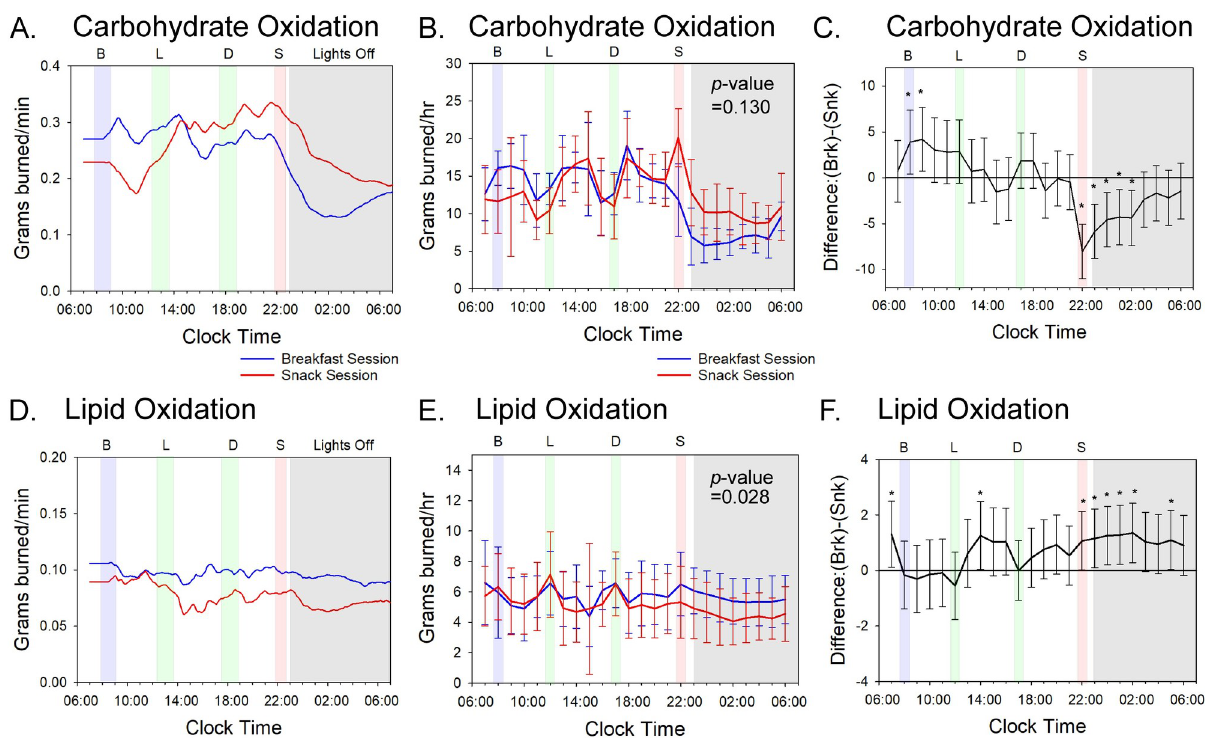
Fig 3. Meal timing alters substrate oxidation; see S5 and S6 Figs and S2E and S2F Table for underlying data and analyses. (A) CO data of a representative subject (#3) calculated from indirect calorimetry measurements as described [26,27].Data are plotted as a 3-h moving average (180-min data points). (B) Average of all subjects for daily CO calculated from indirect calorimetry measurements as described [26,27],and the 56-h time course data are plotted on a modulo-24 h scale. Averaged data for all subjects are organized in 1-h bins. The p -value of 0.130 refers to a pairwise comparison of the average (breakfast − snack) difference values over the full 56-h time course for CO. See S5 Fig for data of all subjects’ CO rates plotted individually. (C) Average hourly pairwise comparison of (breakfast − snack) difference CO values for all subjects. Error bars indicate 95% confidence intervals, and values are based on a mixed-model analysis. Asterisks indicate significant differences ( p -value < 0.05) between breakfast and snack values for the indicated 1-h bins. See S2E Table for the hour-by-hour statistical comparison of the breakfast versus the snack sessions. (D) LO data of a representative subject (#3) calculated from indirect calorimetry measurements as described [26,27].Data are plotted as a 3-h moving average (180-min data points). (E) Average of all subjects for daily LO calculated from indirect calorimetry measurements as described [26,27] and the 56-h time course data are plotted on a modulo-24 h scale. Averaged data for all subjects are organized in 1-h bins. The p -value of 0.028 refers to a pairwise comparison of the average (breakfast − snack) difference values over the full 56-h time course for LO. See S6 Fig for data of all subjects’ LO rates plotted individually. (F) Average hourly pairwise comparison of (breakfast − snack) difference LO values for all subjects. Error bars indicate 95% confidence intervals, and values are based on a mixed-model analysis. Asterisks indicate significant differences ( p -value < 0.05) between breakfast and snack values for the indicated 1-h bins. See S2F Table for the hour-by-hour statistical comparison of the breakfast versus the snack sessions. All panels: the blue line indicates values during the subjects’ Breakfast Sessions and the red line for the subjects’ Snack Sessions. Shading indicates meals and lights off as in Fig 1B and 1C. Error bars indicate ± standard deviation. CO, carbohydrate oxidation; LO, lipid